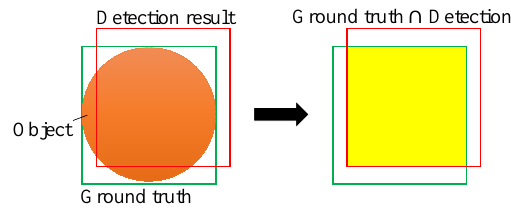
Figure 9. Main concept of the IoU tracker